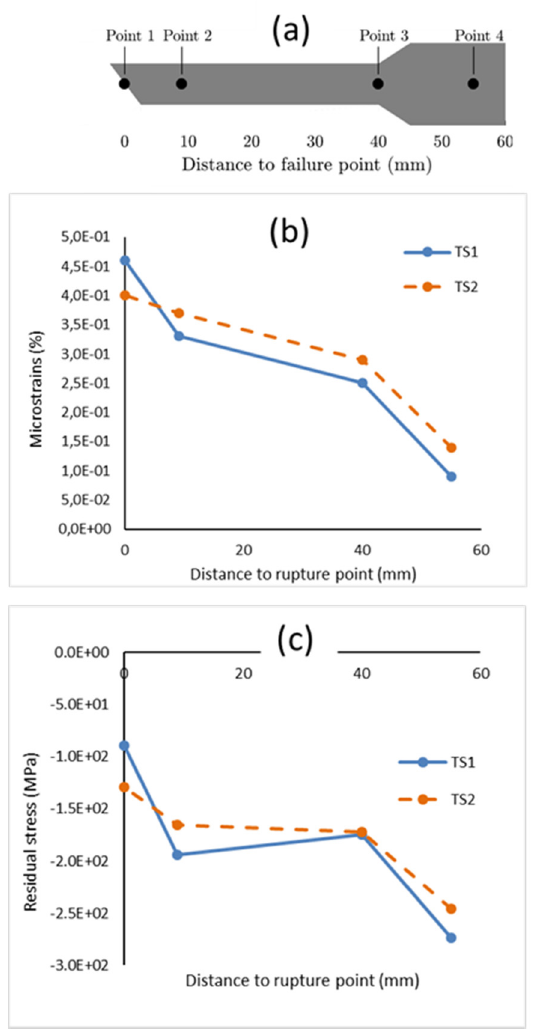
Figure 9. ( a ) Location of the characterization area on the tensile specimen after failure; ( b ) estimations of microstrains; ( c ) residual stress as a function of the distance to the failure line. TS1 is in blue and TS2 is in